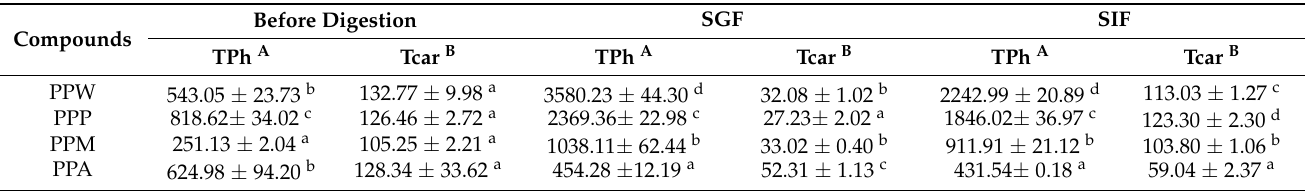
Table 2. Spectrophotometric analysis of bioactive compounds content before and after in vitro gastrointestinal